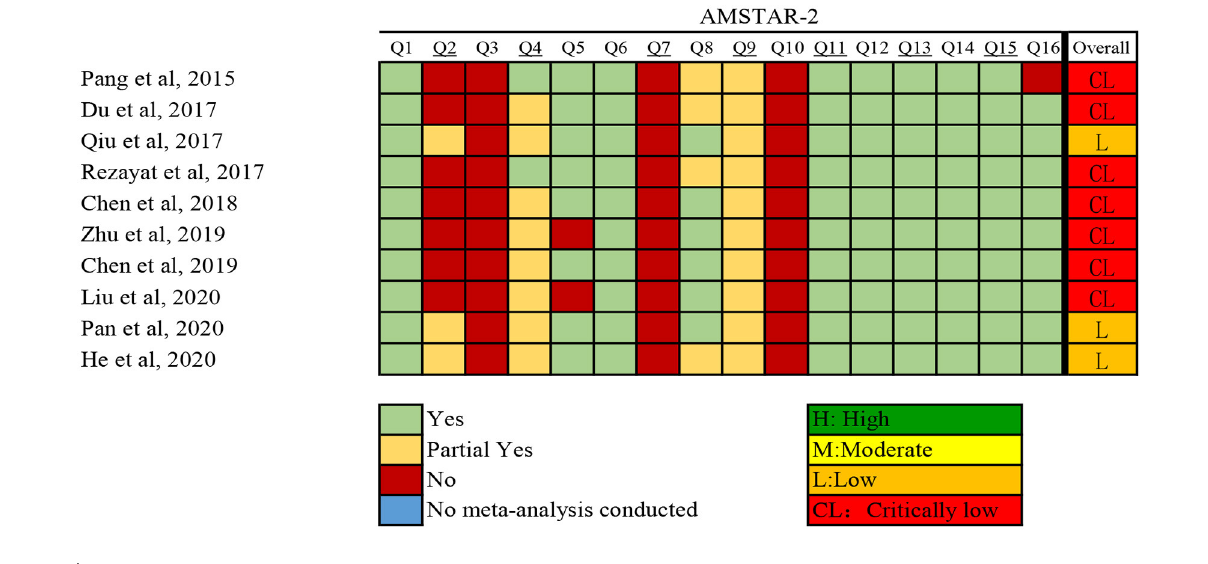
FIGURE 2 | The AMSTAR 2 rating of the included